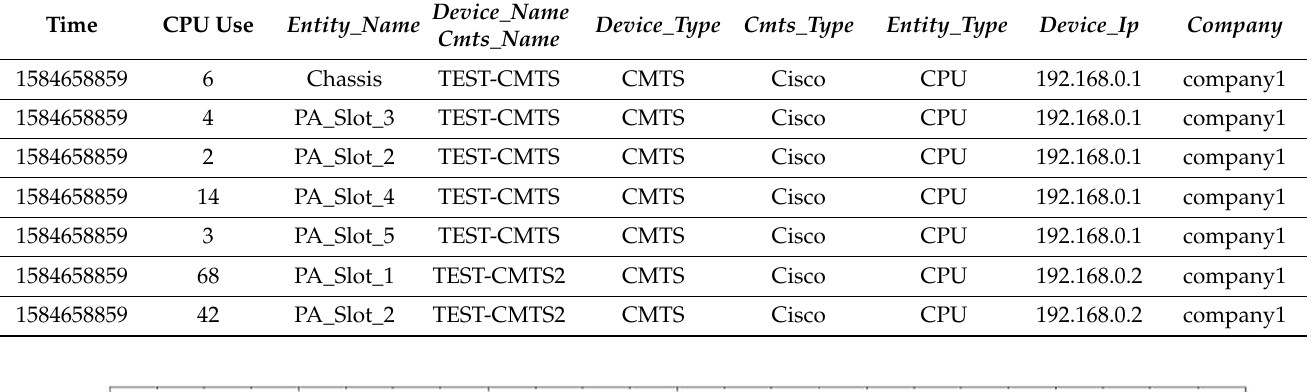
Figure 4. CMTS CPU utilization per unit.